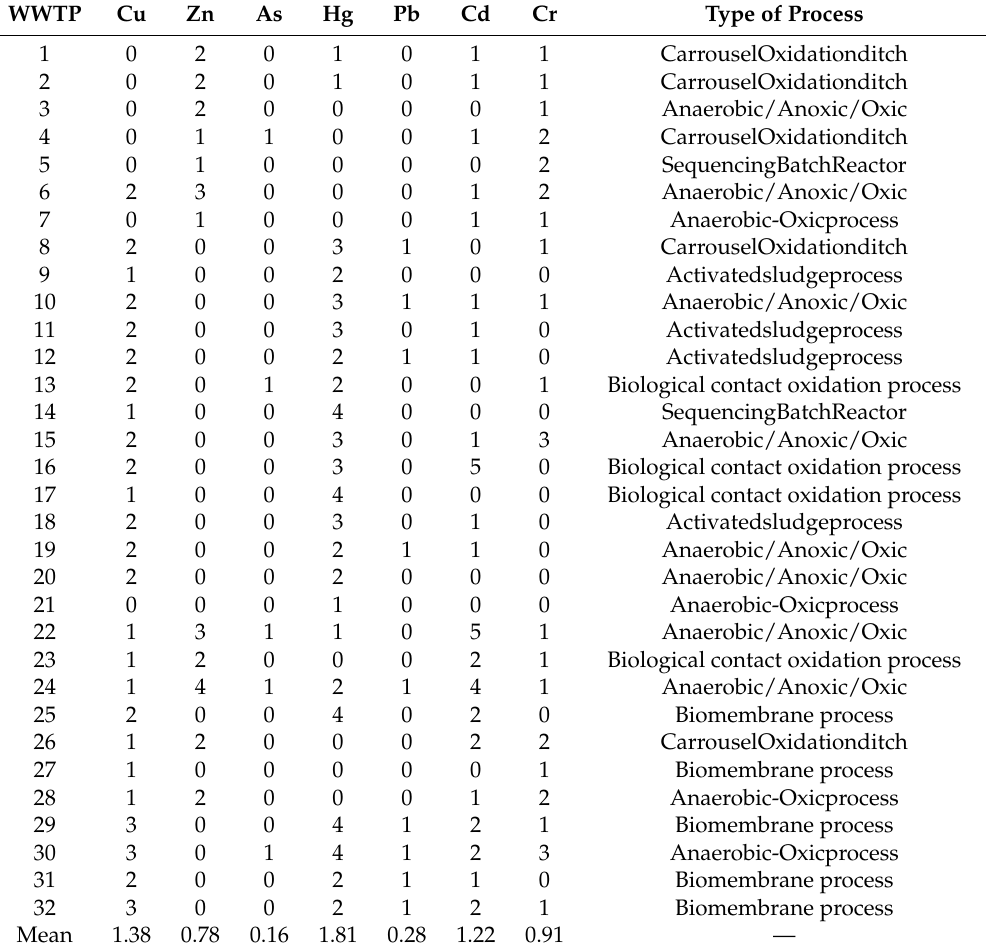
Table 5. Classes of contamination by I geo of sewage sludge for different WWTPs in